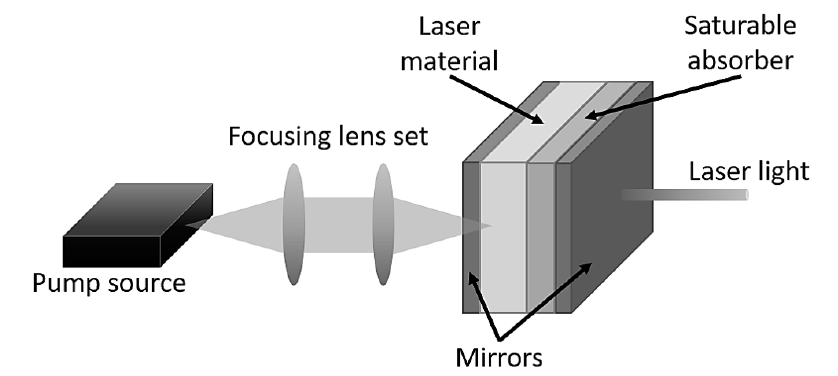
Figure 10. Schematic diagram of a microchip